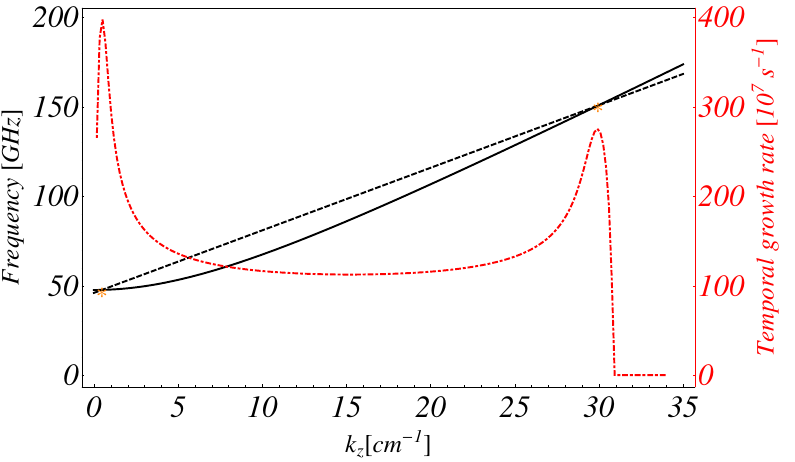
Figure 12. Frequency value (left axis) corresponding to the interaction of the beam (dashed line) with the dispersion curve of the operating mode TE 23 (continuous line) and growth rate (dot-dashed line) using the the parameters reported in Table